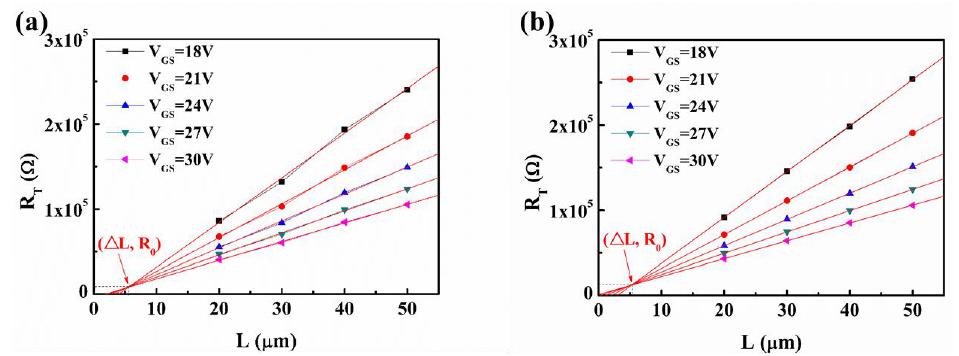
Figure 2. Plot of the total resistance ( R T ) versus the channel length ( L ) for a-STO TFTs with different S/D electrodes: ( a ) ITO and ( b ) Mo. The fixed channel width ( W ) is 100 µm, and the various channel lengths ( L ) are 20, 30, 40, and 50 µm.